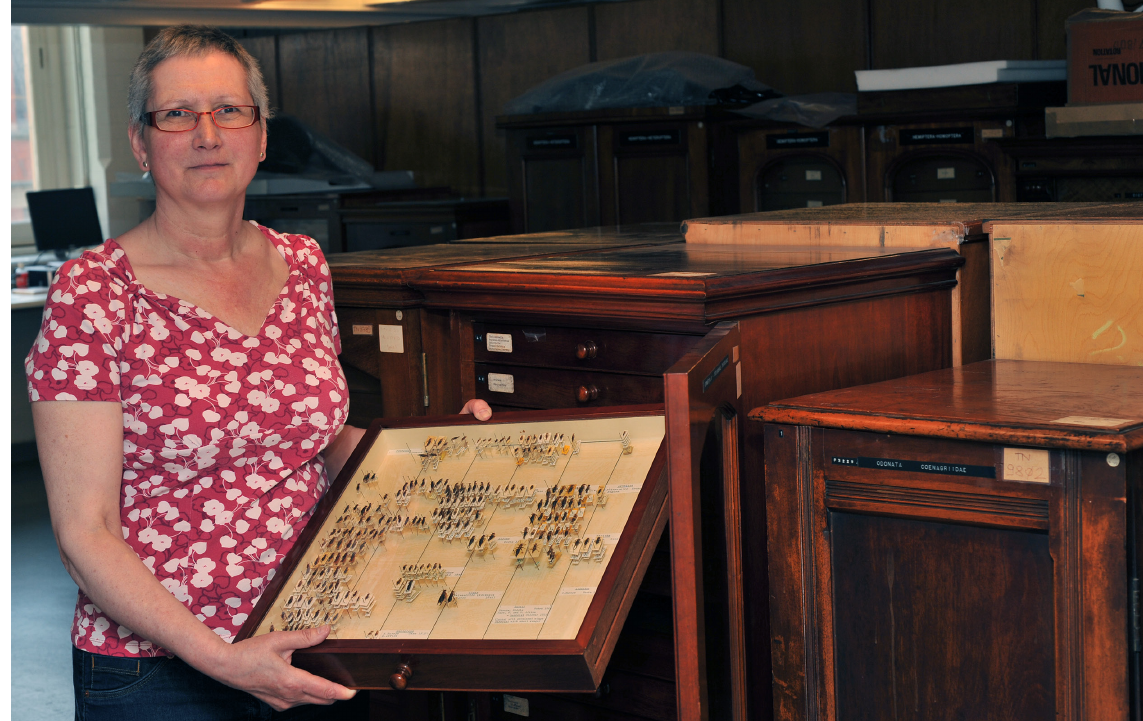
Fig. 1. The author and two of the three cabinets (drawers 21–60) housing the dry, mounted specimens in the worldwide Dermaptera collection, the Manchester Museum.